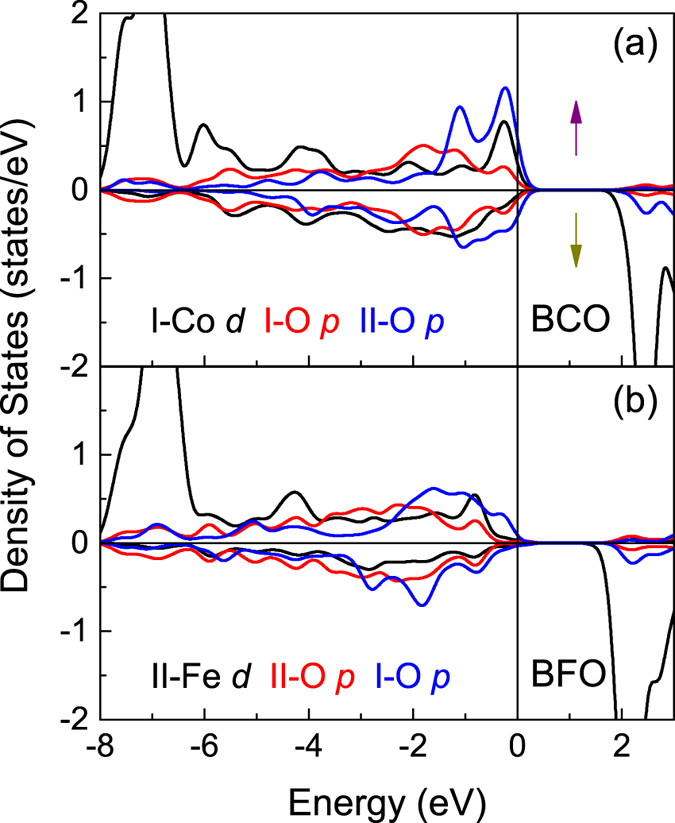
DOS for Fe, Co and O ions in interfacial regions of model CoO2-BiO.EF = 0 eV.